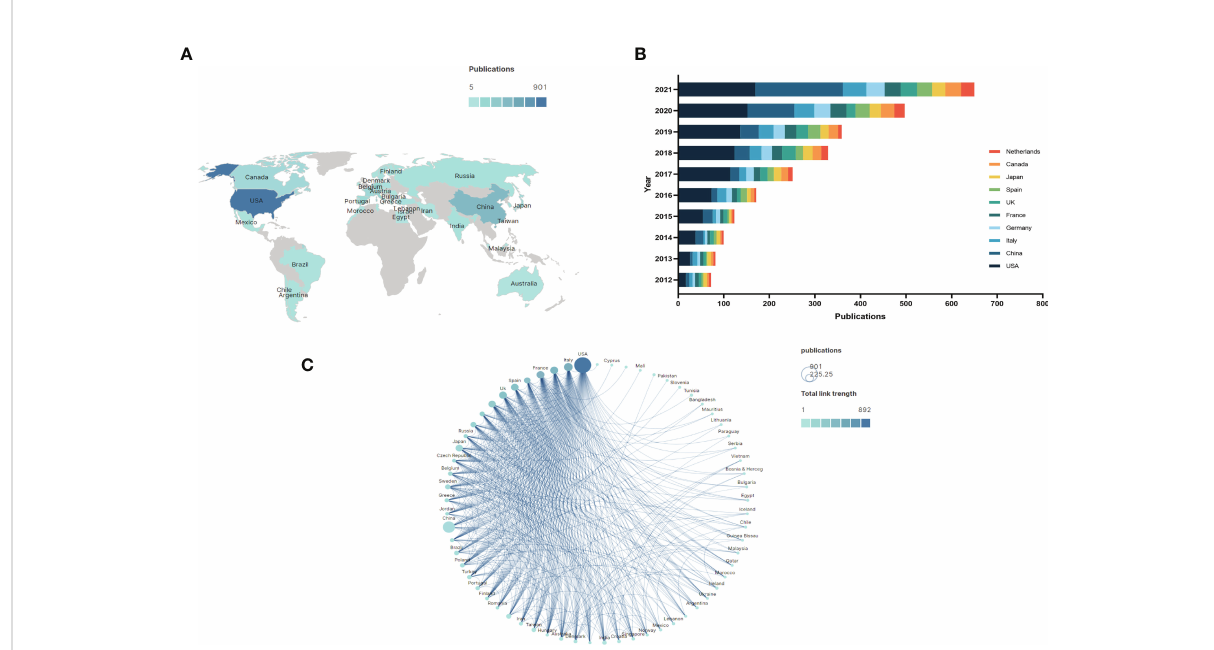
FIGURE 3 (A) The changing trend of the annual publication quantity in the top 10 countries/regions from 2012 to 2021. (B) The international collaborations ’ visualization map of countries/regions.